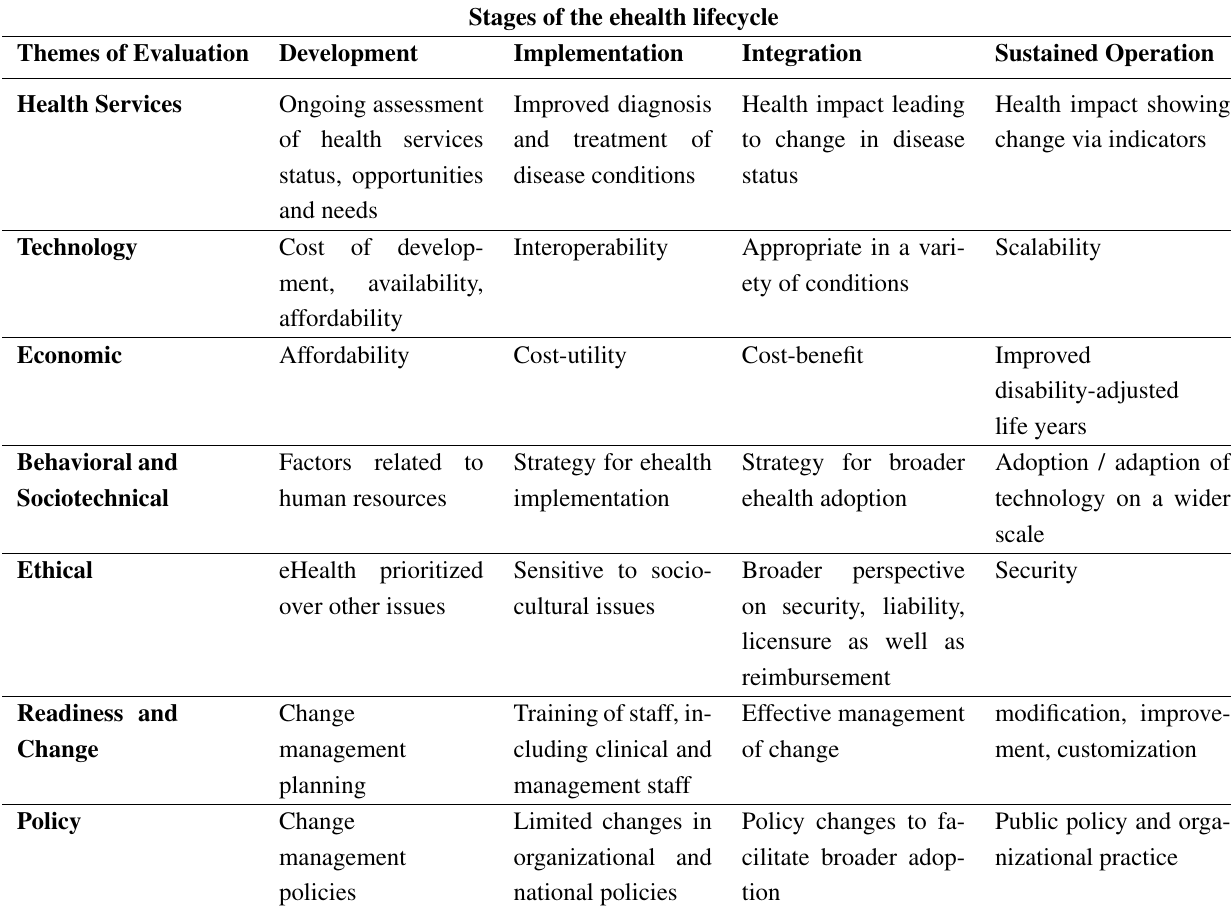
Table 7. Extract from the Khoja–Durrani–Scott (KDS) Evaluation Framework [26]. Stages of the ehealth